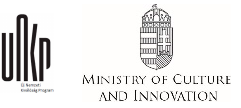
samples. Table S4: Analysis of the multilayered, sutured vertical samples. Table S5: Analysis of the multilayered, sutured horizontal